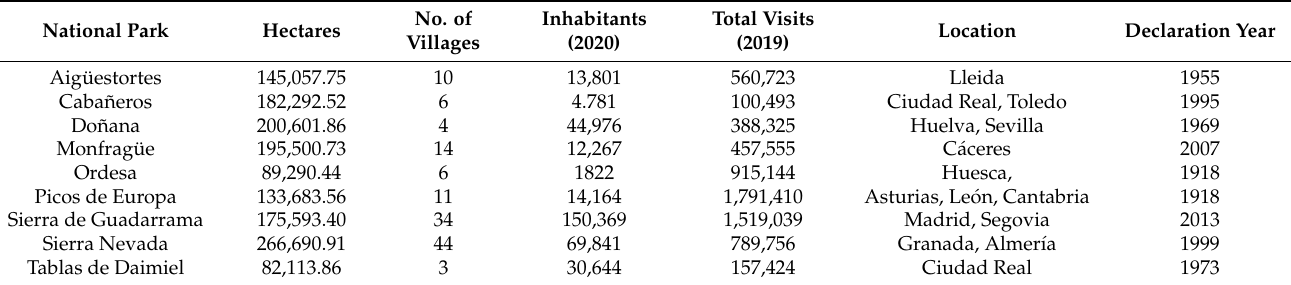
Table 1. Characteristics of the national parks under study.